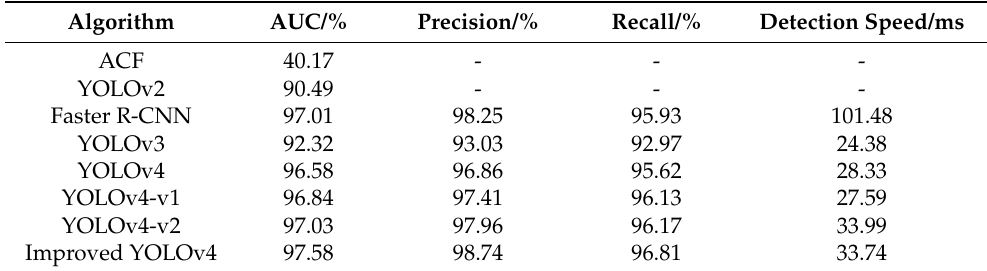
Table 6. Traffic light detection performance index in the LISA data